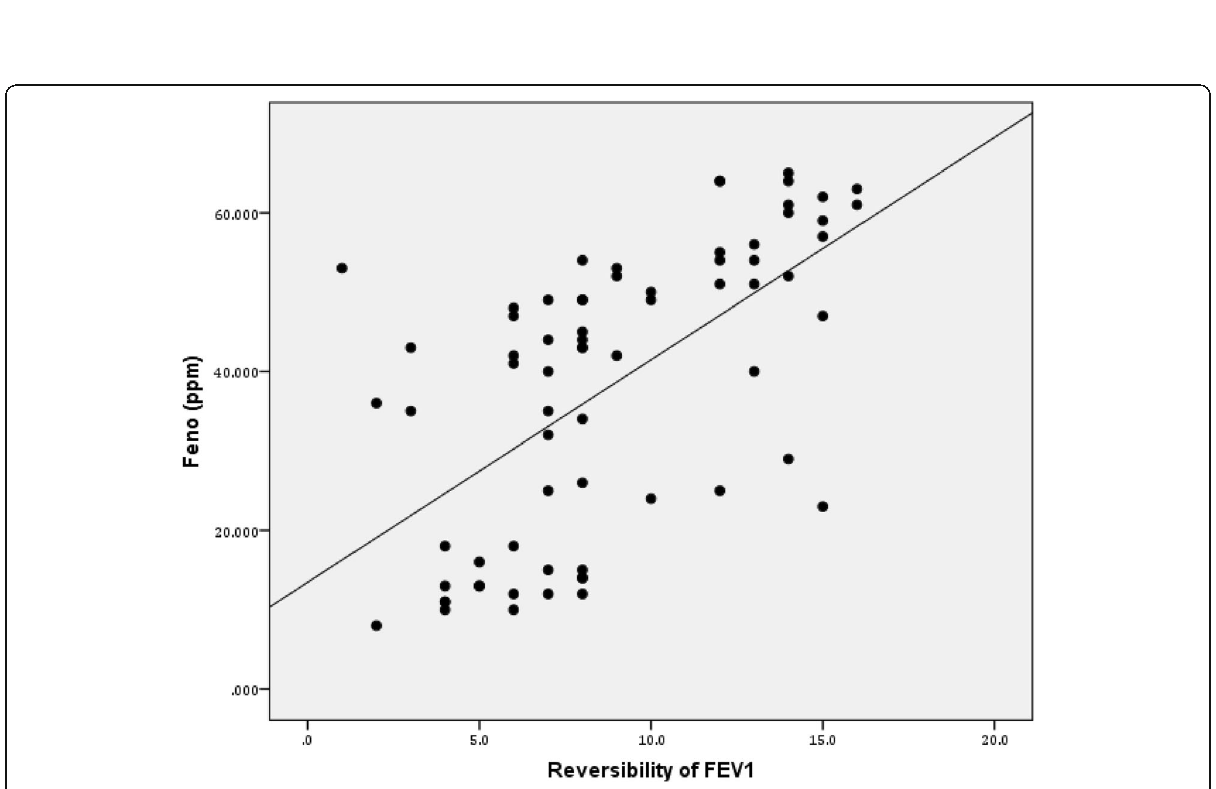
Fig. 2 Scatter dot graph showing significant positive correlation between Feno and post-treatment reversibility of